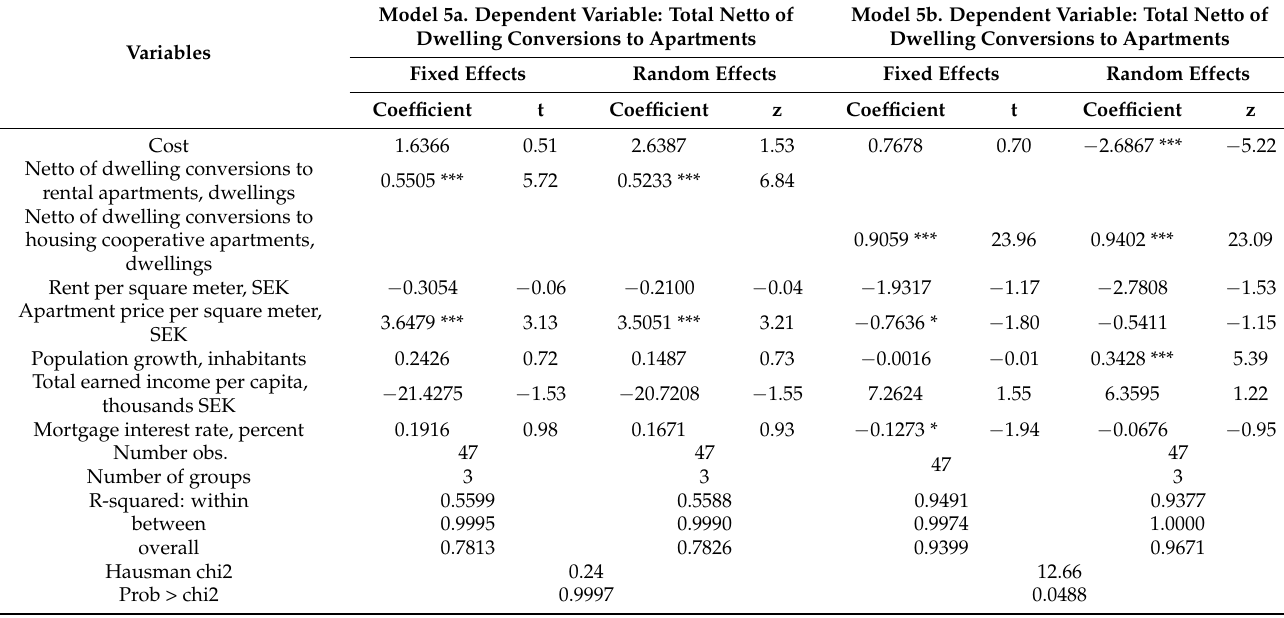
Table 8. Displacement effects for dwelling